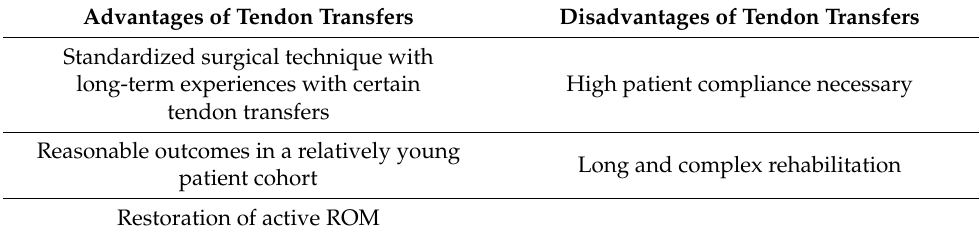
Table 4. Advantages and disadvantages of tendon